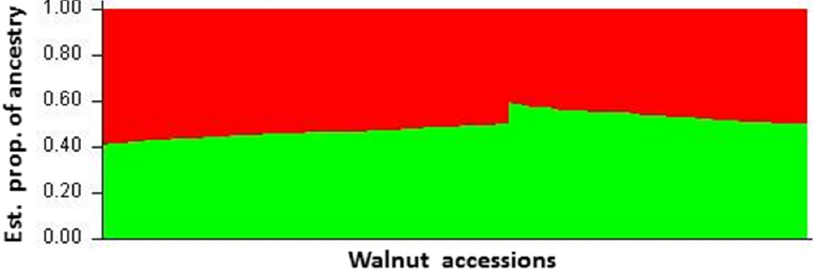
Figure 4. Population structure inference for 215 walnut ( Juglans regia L.) accessions as assigned using STRUCTURE [47] and the admixture option for K = 2 (see text for details). Vertical bars represent individual accessions. The length of segment color in each vertical bar represents the proportion contributed by each of the two populations in the model (represented by different colors) to that individual.